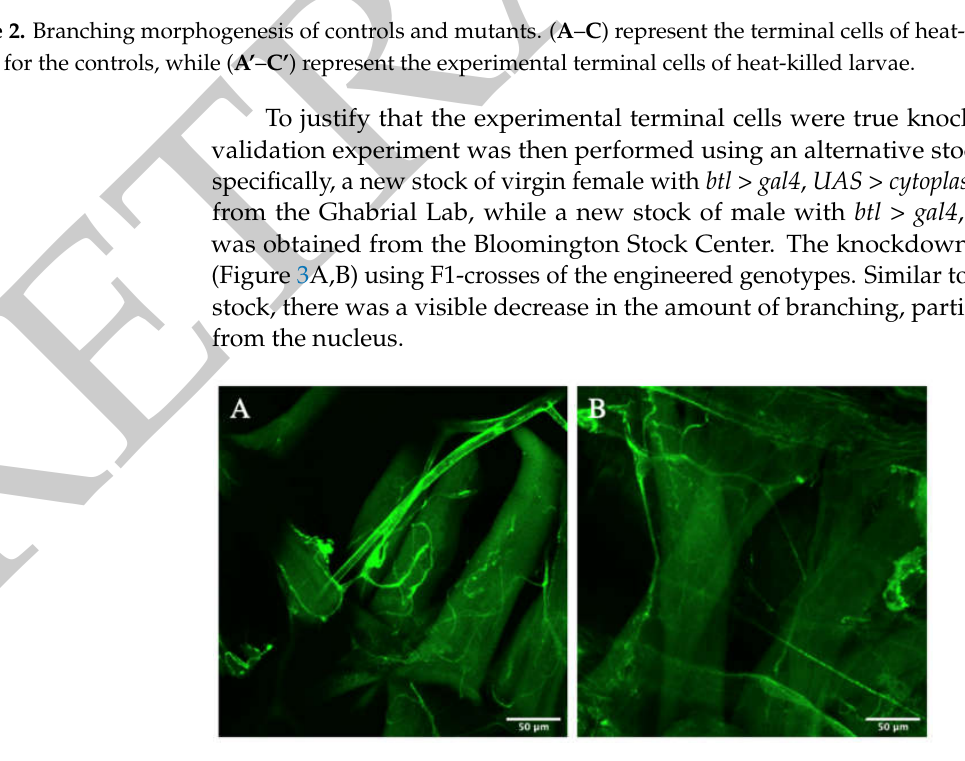
Figure 3. Branching morphogenesis of mutants from alternative stock. ( A , B ) represent the experi- mental terminal cells of heat-killed larvae using an alternative stock of fruit